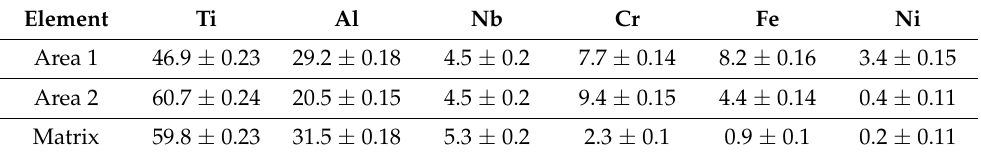
Table 2. Chemical composition (in wt.%) of different regions of Figure 4c.